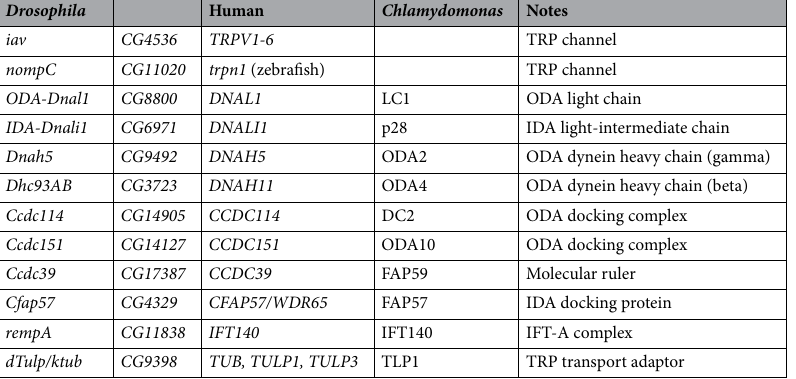
Table 1. Genes/proteins in this